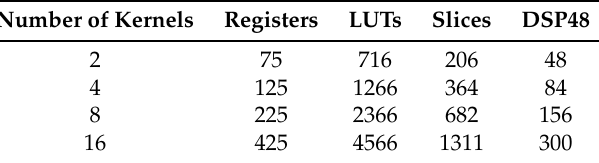
Table 4. Resource utilization of the XOR gate dataset—fixed point.